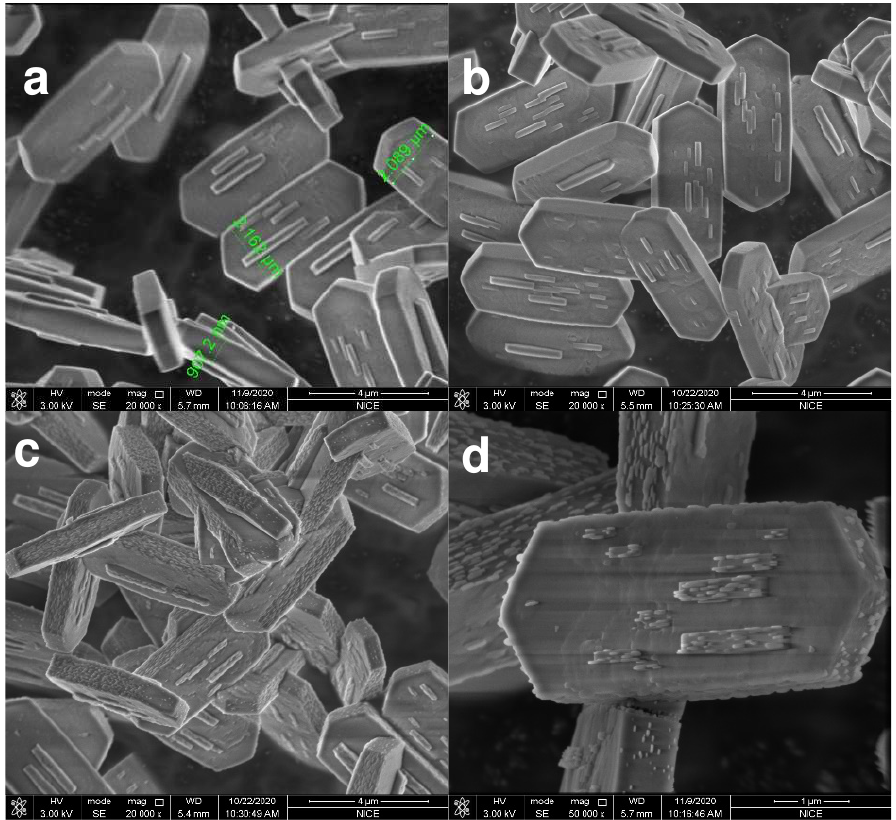
Figure 2. SEM images of ( a ) HZSM-5, ( b ) HZSM-5@1%S-1, ( c ) HZSM-5@2.5%S-1, and ( d ) HZSM- 5@4%S-1 catalysts, as prepared. Table 1. Textural properties of the as prepared parent HZSM-5 and HZSM-5@silicalite-1